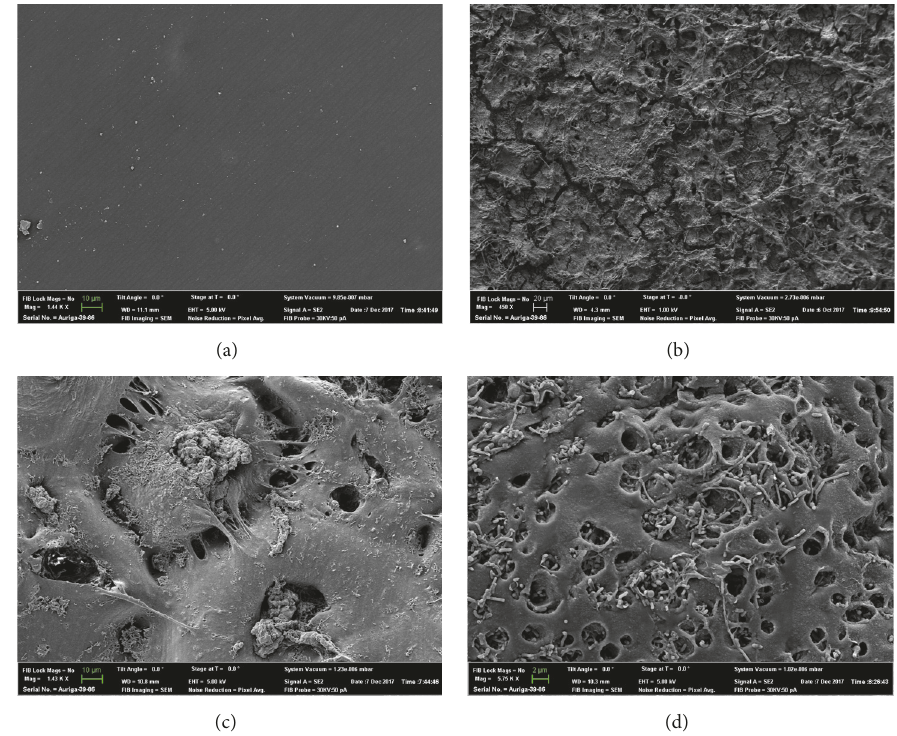
Figure 2: Scanning electron microscopy (SEM) images of silicone esophagostomy tubes. (a) The luminal surface of a reference tube. The surface is mostly regular with mild imperfections. The scale bar is equal to 10 𝜇 m and the original magnification is 1.44K. Photo credit: John Dunlap. (b) Thick biofilm with crevices covering the luminal surface of a tube exposed for 77 days in a cat (case 1). Dense mats of fungal mycelia are visible. The scale bar is equal to 20 𝜇 m and the original magnification is 450x. Photo credit: John Dunlap. (c) Biofilm and multiple large pores in the luminal wall of the intraesophageal portion of a tube exposed for 246 days in a dog (case 2). The scale bar is equal to 10 𝜇 m and the original magnification is 1.43K. Photo credit: John Dunlap. (d) Mixed biofilm with bacteria and yeast, as well as a multitude of pores, in the luminal wall of the extraesophageal portion of a tube exposed for 246 days in a dog (case 2). The scale bar is equal to 2 𝜇 m and the original magnification is 5.75K. Photo credit: John